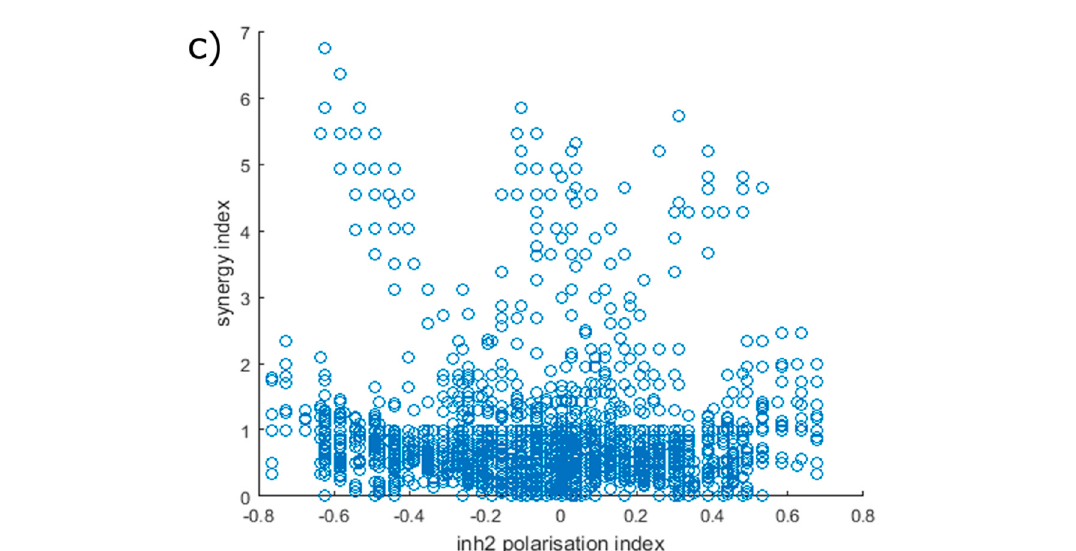
Figure 5. Effects of the simultaneous inhibition of 2 nodes. ( a ) Changes in the polarization index in response to combined inhibition. Areas that shift predominantly towards one state are highlighted (as ROI#1 and #2), similar to Figure 4. They are slightly larger, with approximately 37% of target combinations mainly causing a shift in a regenerative direction and 11% towards an inflammatory state (compared to 30 and 7% for individual target inhibition, see Figure 4.) ( b ) Synergy index in all conditions. The ROIs present in previous heatmaps are not clearly visible, except the mostly inert zone (marked) where the inhibition has little to no effect. High synergy spots appear scattered compared to the ∆ pI. The axes in ( a , b ) are sorted for presentation purposes, and the order is the same in both, based on ∆ pI. ( c ) Synergy index is achieved in relation to a shift in the polarization index. Values are somewhat cropped due to the τ adjustment parameter (see Equation (3) in Materials and Methods) capping synI at ∆ pI/ τ